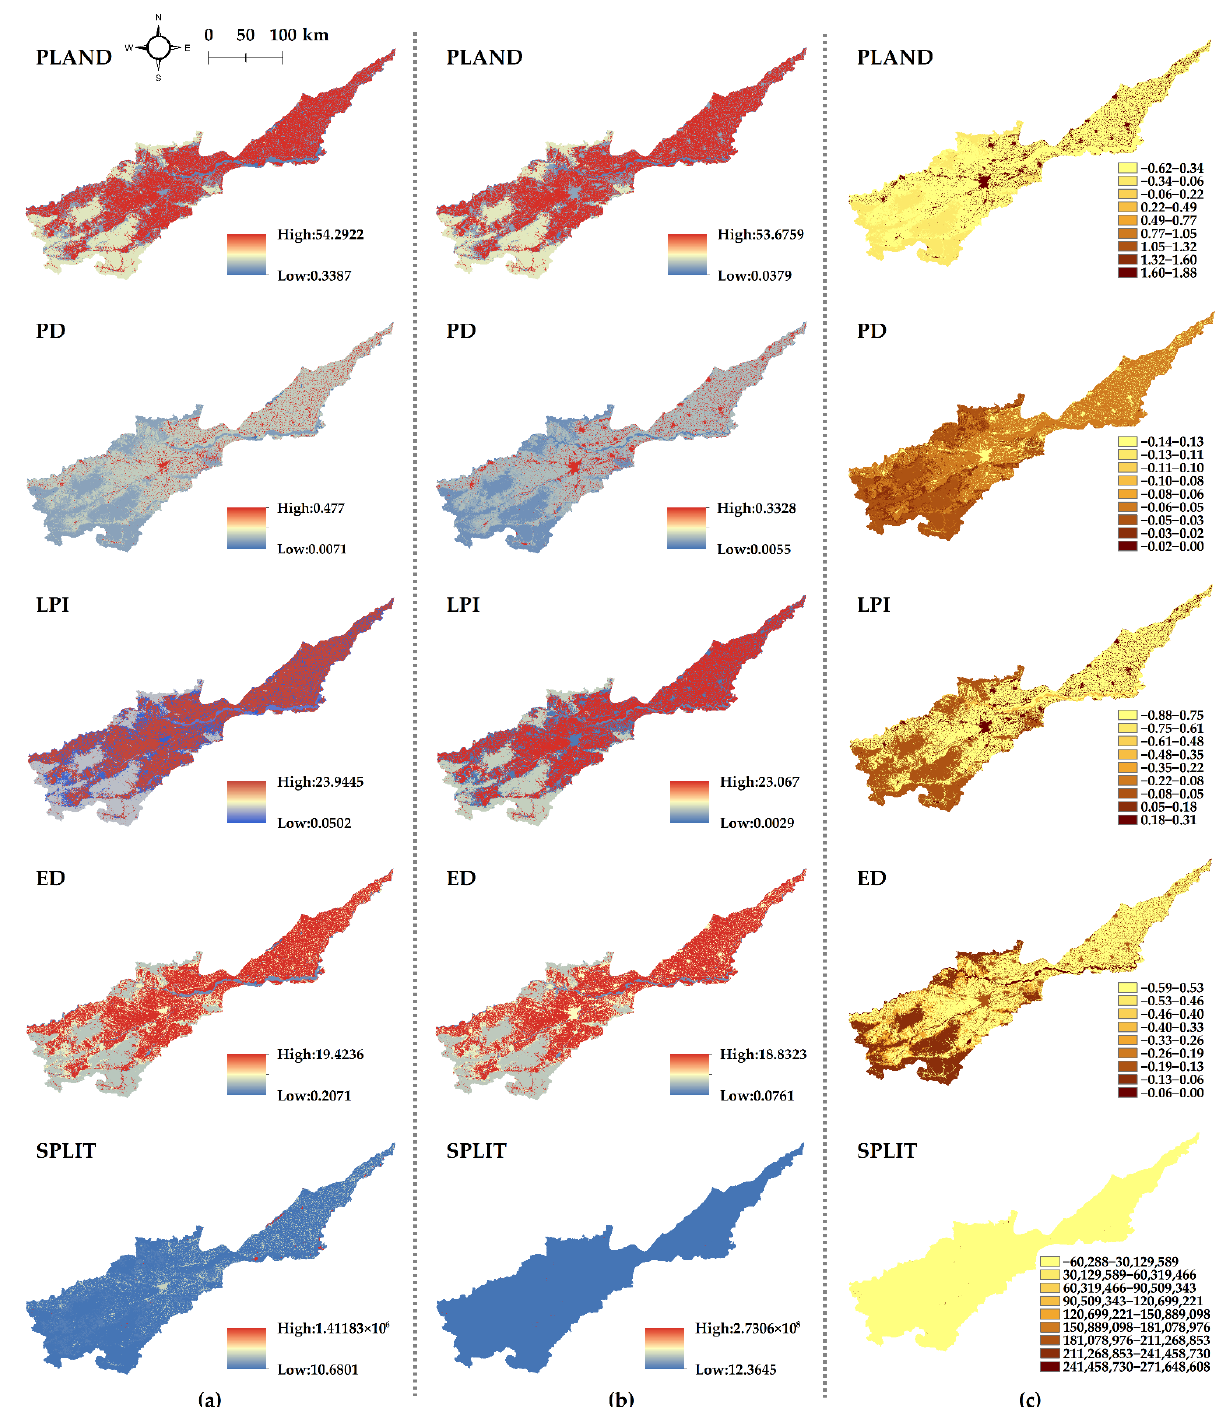
Figure 9. Spatial distribution of the changes in landscape metrics between ( a ) 1990 and ( b ) 2020, with ( c ) showing the results of subtracting the 1990 indices from those of 2020.